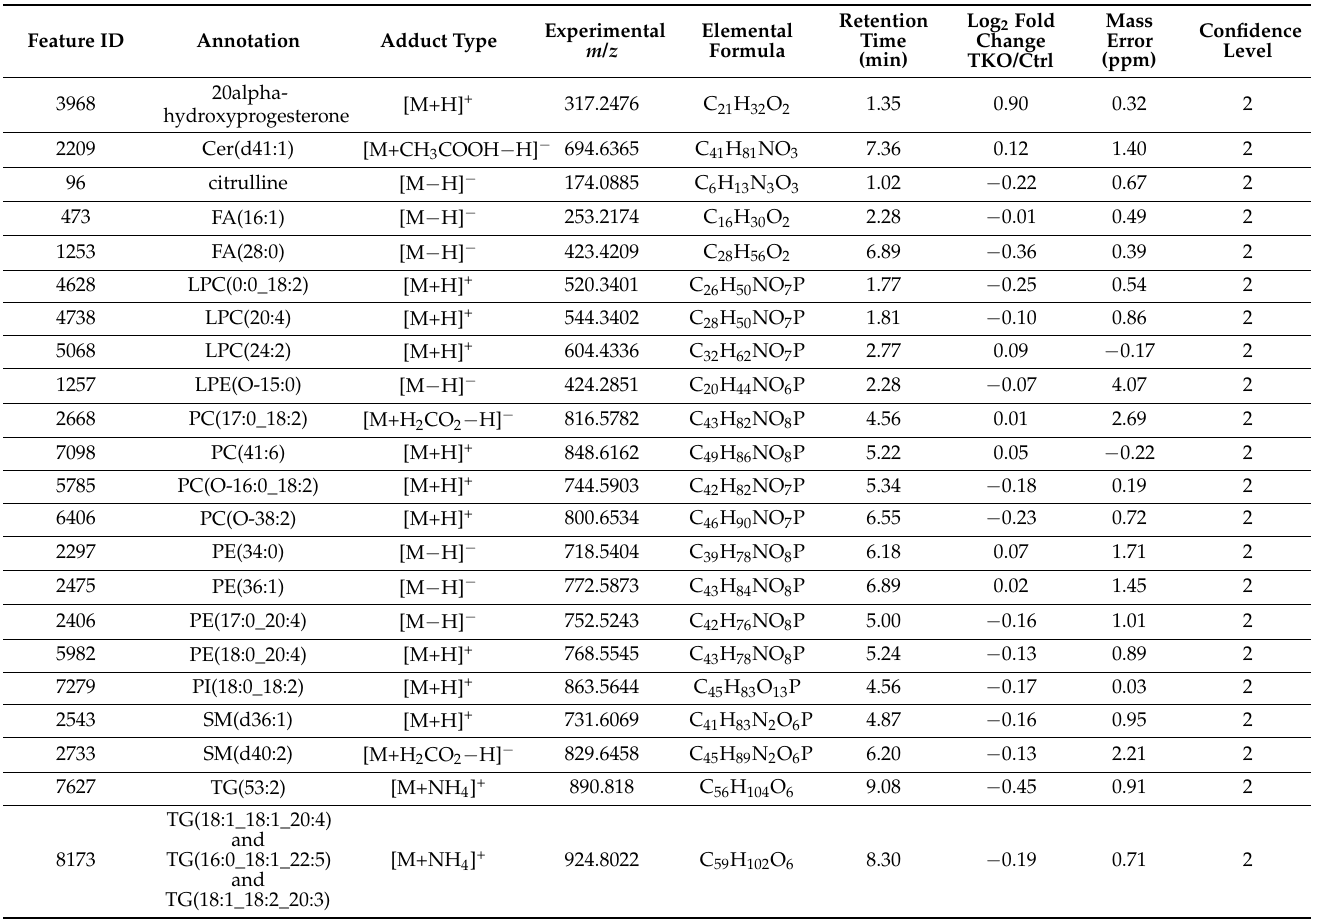
Table 2. Optimized discriminant lipid panel for early stage HGSC. Variables were selected using a genetic algorithm (GA) for optimum discrimination of 37–60 %lifetime TKO and TKO control samples. Proposed metabolite annotation, experimental monoisotopic m / z value, elemental formula, chromatographic retention time (min), mass error (ppm), main adduct type detected, abundance log-transformed fold changes, and metabolite annotation confidence level are shown. Fold changes were calculated as the base 2 logarithm of the average abundance ratios between TKO and TKO controls in the 37–60 %lifetime group. Positive values indicate higher levels in TKO serum samples and negative values indicate lower levels in TKO serum samples compared to TKO controls. The confidence level for metabolite annotation was assigned as (1) exact mass, isotopic pattern, reten- tion time, and MS/MS spectrum of a chemical standard matched to the feature. (2) exact mass, isotopic pattern, retention time, and MS/MS spectrum matched to an in-house spectral database or literature spectra (3) putative ID assignment based only on elemental formula match. (4)